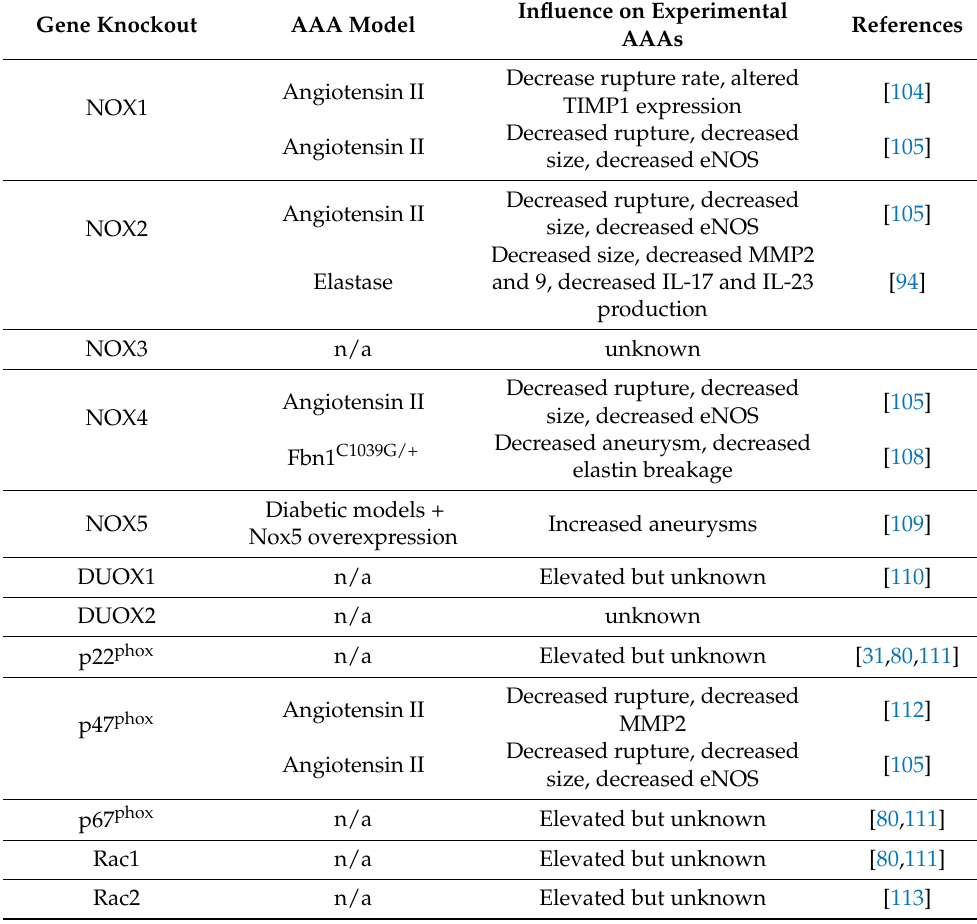
Table 2. Genetic elimination of NOX family members in experimental